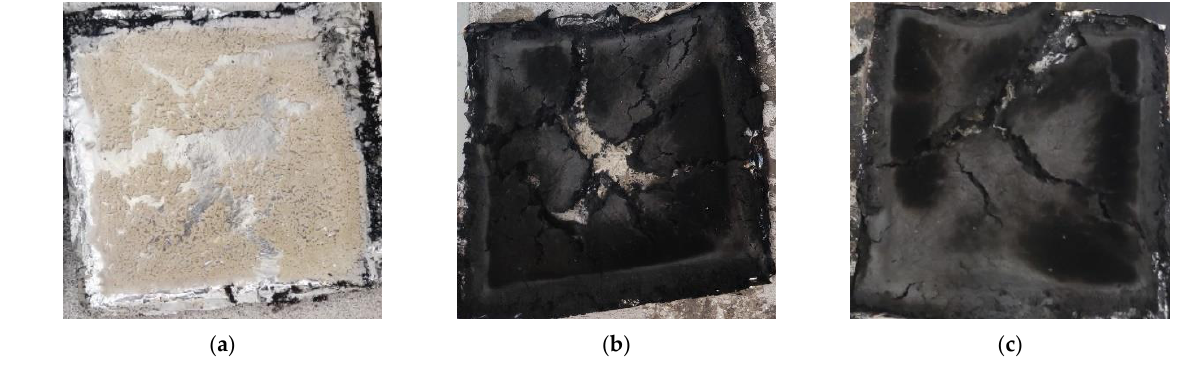
Figure 4. ( a ) Heat release rate and ( b ) total heat release of composites.